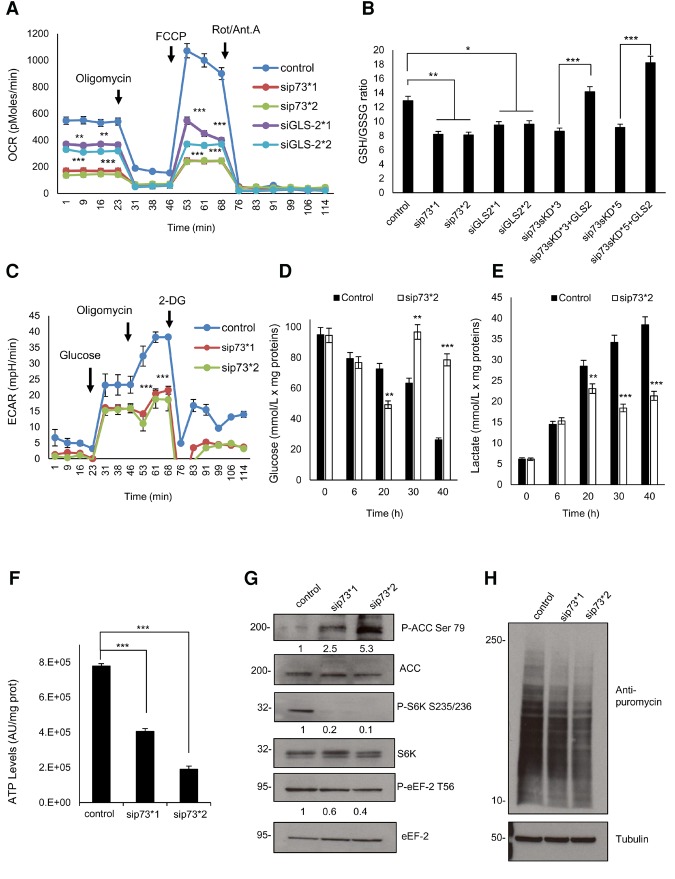
p73KD induces mitochondrial defects and activates AMPK signaling. (A) DAOY cells were transfected with scramble, sip73 (sip73*1, 2671; sip73*2, 115666), or siGLS-2 (siGLS-2*1, s25941; siGLS-2*2, s223735). OCR in response to a mitochondrial stress test was recorded to construct functional bioenergetic profiles. A minimum of five different samples was analyzed for each group. (**) P < 0.001; (***) P < 0.0001, unpaired two-sided t-test. Data from one representative experiment out of three are shown. (B) The reduced and oxidized glutathione ratio was measured in DAOY cells after transient transfection with scramble, sip73*1, sip73*2, siGLS-2*1, and siGLS-2*2 for 24 h. DAOY cells were infected with an empty vector or with shRNA (p73sKD*3 and p73sKD*5) alone or transfected with Flag-GLS-2-expressing vector for 48 h. n = 3. Data were mean ± SD. (*) P < 0.01; (**) P < 0.001; (***) P < 0.0001. (C) DAOY cells were transfected with scramble or sip73 (sip73*1, 2671; sip73*2, 115666). Extracellular acidification rate (ECAR) was measured in response to a mitochondrial stress test. A minimum of five different samples was analyzed for each group. (***) P < 0.0001, unpaired two-sided t-test. Data from one representative experiment out of three are shown. (D,E) DAOY cells were transfected with scramble or sip73*2. After 8 h of transfection, the medium was changed, and samples were collected after 6, 20, 30, and 40 h. The results show glucose consumption (D) or lactate production (E). Columns indicate mean ± SEM. n = 4. (**) P < 0.001; (***) P < 0.0001. (F) DAOY cells were transiently transfected with scramble, sip73*1, or sip73*2. After 48 h, cells were collected, and ATP levels were determined. Columns indicate mean ± SEM. n = 4. (***) P < 0.0001. (G) DAOY cells were transfected with scramble, sip73*1, or sip73*2. After 48 h a Western blot was performed for ACC, P-ACC, S6K, P-S6K, eEF-2, and P-eEF-2. Intensity analysis is shown below each lane; scramble was considered 1. (H) DAOY cells were transfected with scramble, sip73*1, or sip73*2. After 48 h, cells were treated for 1 h with 2.5 mg/mL puromycin. Next, cells were collected, and a Western blot of lysed cells was probed with a primary anti-puromycin antibody. Tubulin was used as a loading control. (2-DG) 2-deoxy-D-glucose.